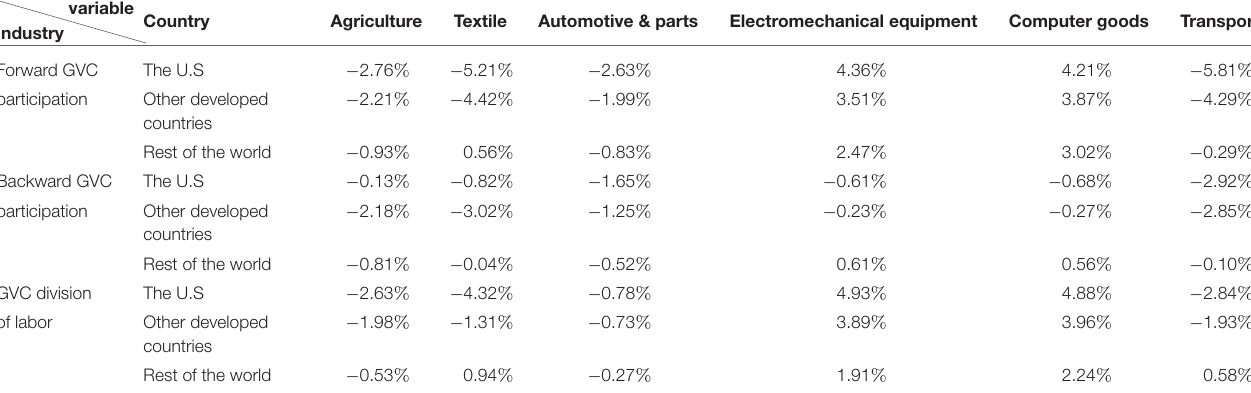
TABLE 4 | The pandemic’s impact on different Chinese manufacturing sectors in regard to GVC reconfiguration. variable Country Industry